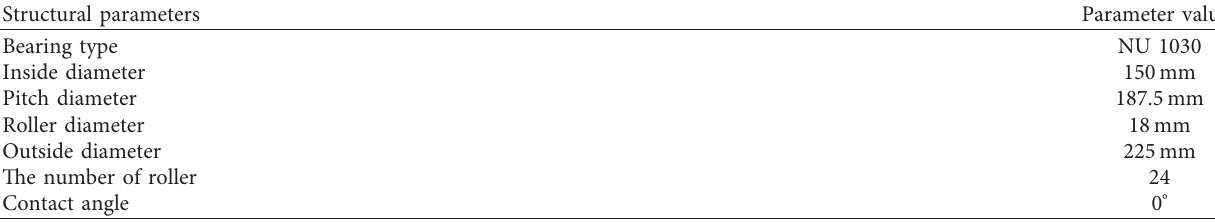
Table 3: Structural parameters of rolling bearing.